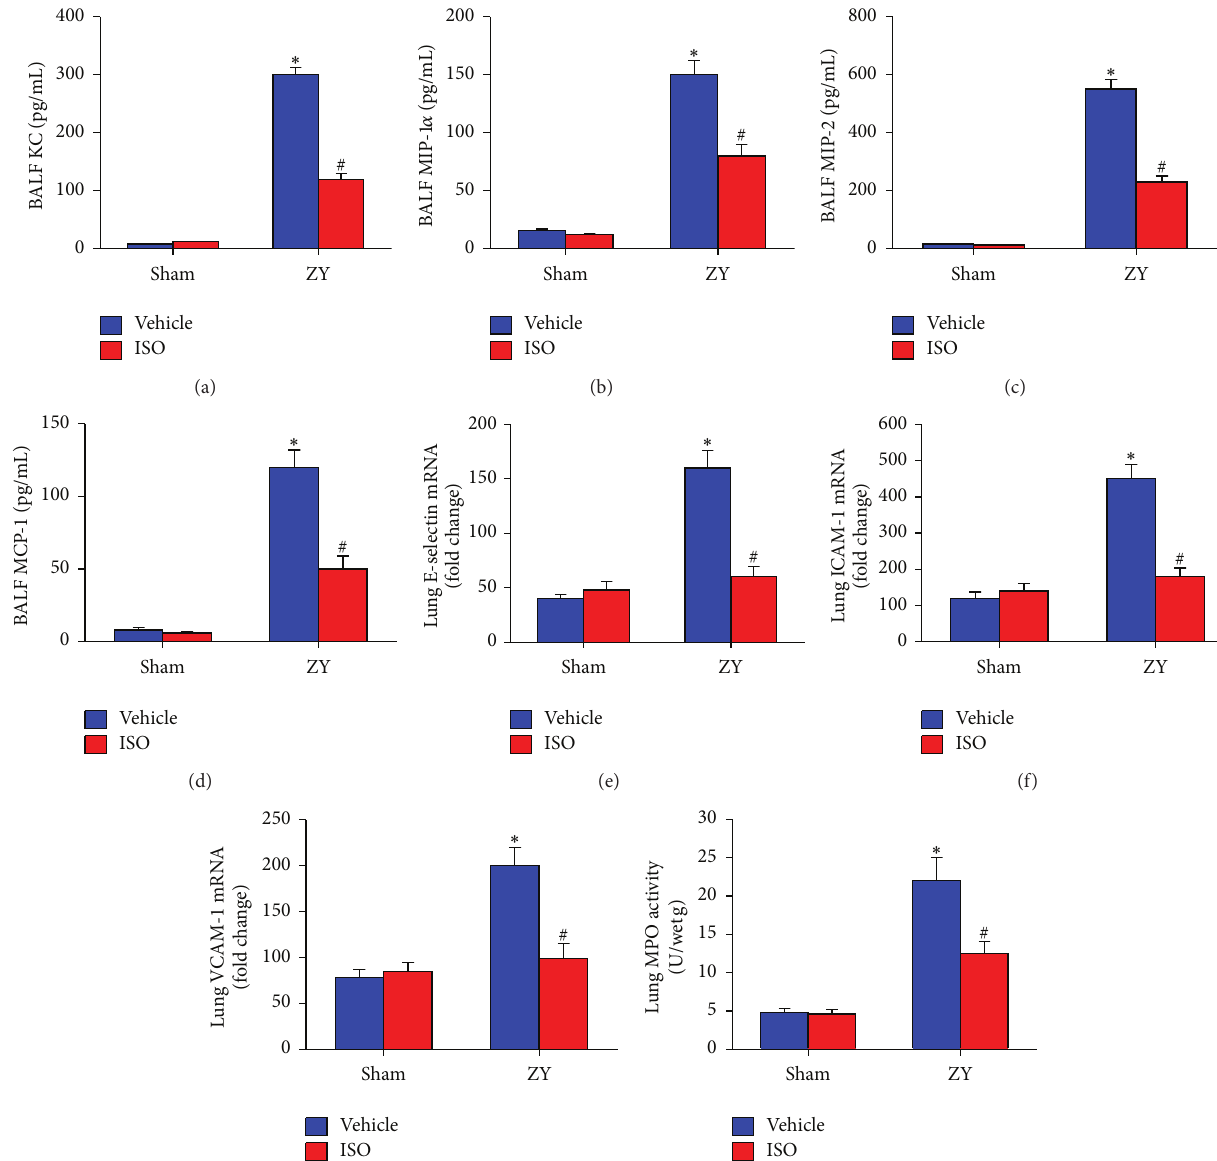
Figure 7: Effects of 0.7% ISO treatment on chemokine production, endothelial adhesion protein expression, and neutrophil recruitment in ZY-treated lung at 24hrs. Levels of the following chemokines in BALF were measured by ELISA: (a) keratinocyte-derived chemokine (KC); (b) macrophage inhibitory protein-1 𝛼 (MIP-1 𝛼 ); (c) macrophage inhibitory protein-2 (MIP-2); (d) monocyte chemoattractant protein- 1 (MCP-1). The mRNA expression of the following endothelial adhesion molecules in lung tissue from all groups was measured by qPCR: (e) E-selectin; (f) ICAM-1; (g) VCAM-1. Lung MPO activity is shown in (h). The animals were treated as shown in Figure 1(a). Data represent mean ± SD ( 𝑛 = 10 mice per group). ∗ 𝑃 < 0.05 versus sham + vehicle; # 𝑃 < 0.05 versus ZY +